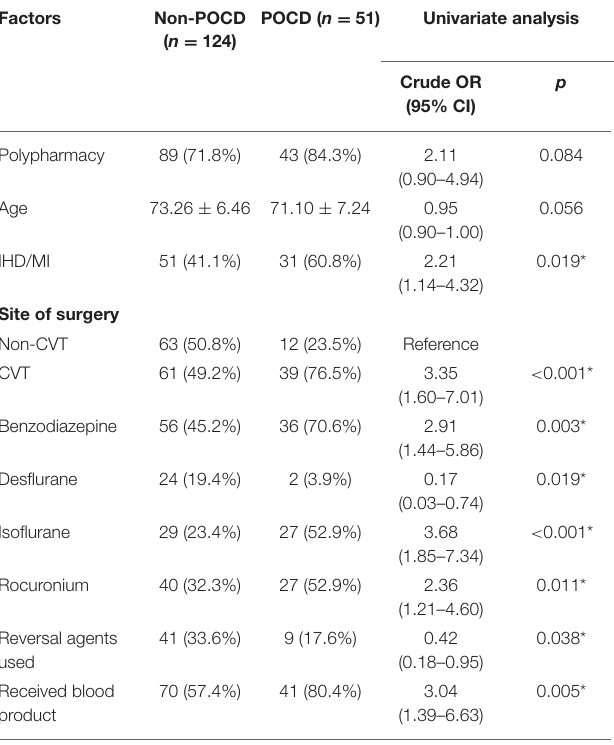
TABLE 5 | Univariate analysis to identify factors that are potentially independently associated with postoperative cognitive dysfunction (POCD) in older adult patients after major surgery.